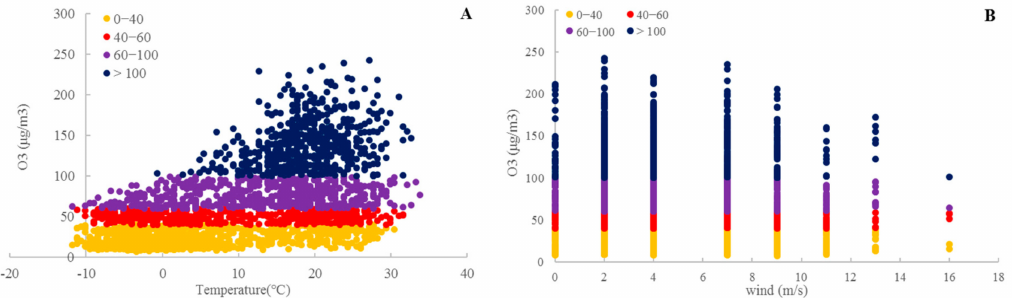
Figure 12. Correlations between the O 3 concentration and meteorological factors. ( A ) temperature; ( B ) wind